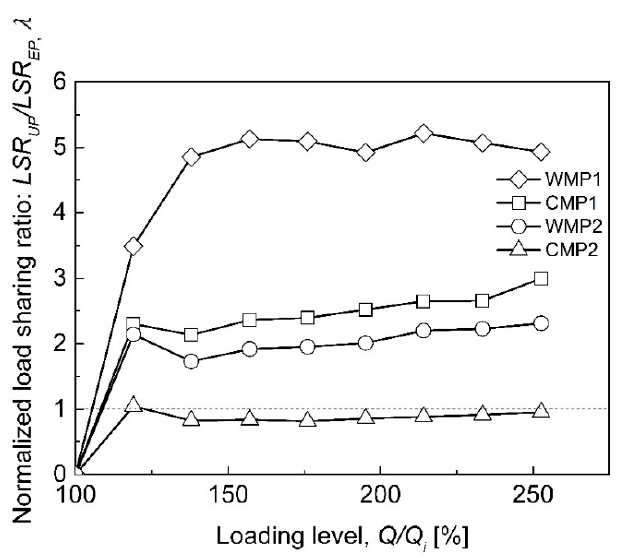
Figure 12. Load sharing ratio of the underpinning pile (UP) normalized by that of the existing pile (EP) plotted with respect to the additional loading level.